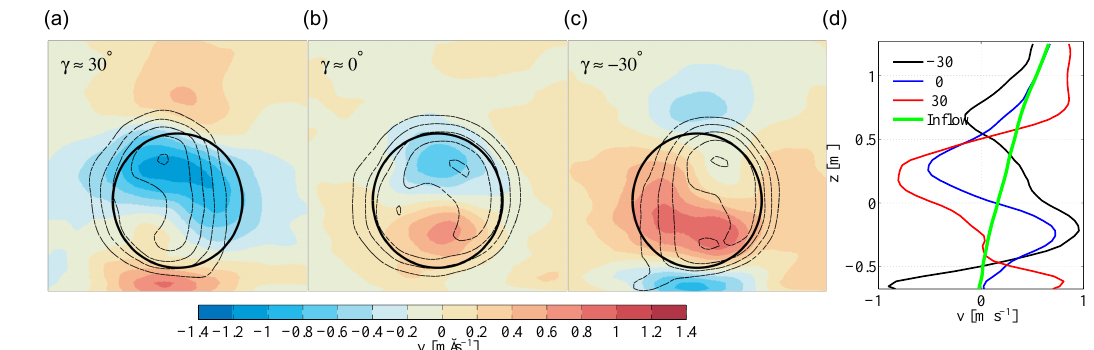
Figure 7. (a–c) Residual cross stream component of the flow at x 2 = 2D downstream of the wind turbine for the same simulations as in Fig. 5. Positive (negative) values stand for a flow to the right (left). Dashed contours denote the position of the wake deficit. (d) Vertical profile of the total v component at y 0 and x 2 , and the average inflow profile.